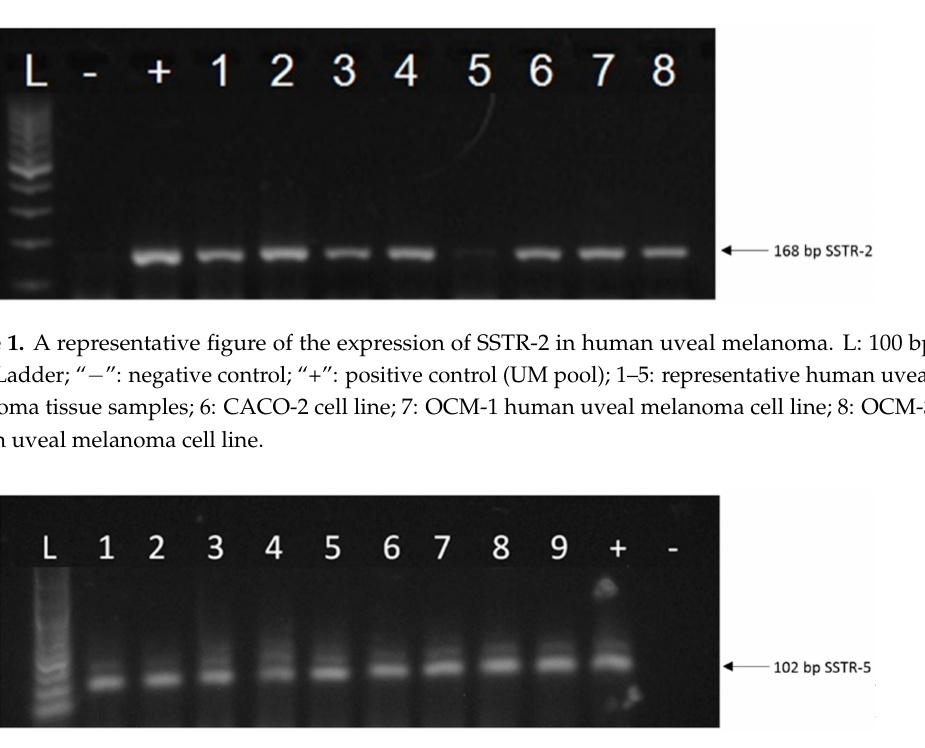
Figure 2. A representative figure of the expression of SSTR-5 in human uveal melanoma. L: 100 bp DNA Ladder; 1–6: representative human uveal melanoma tissue samples; 7: CACO-2 cell line; 8: OCM-1 human UM cell line; 9: OCM-3 human UM cell line. “+”: positive control (UM pool); “ − ”: negative